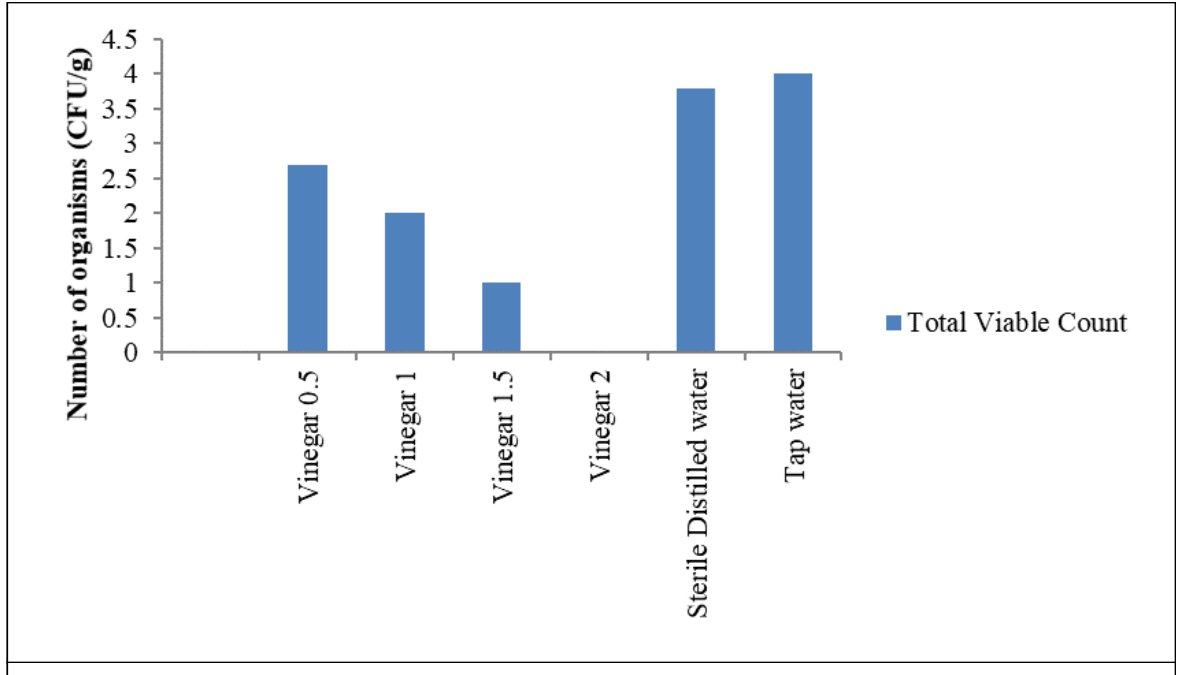
Figure 1: Mean total viable microbial count